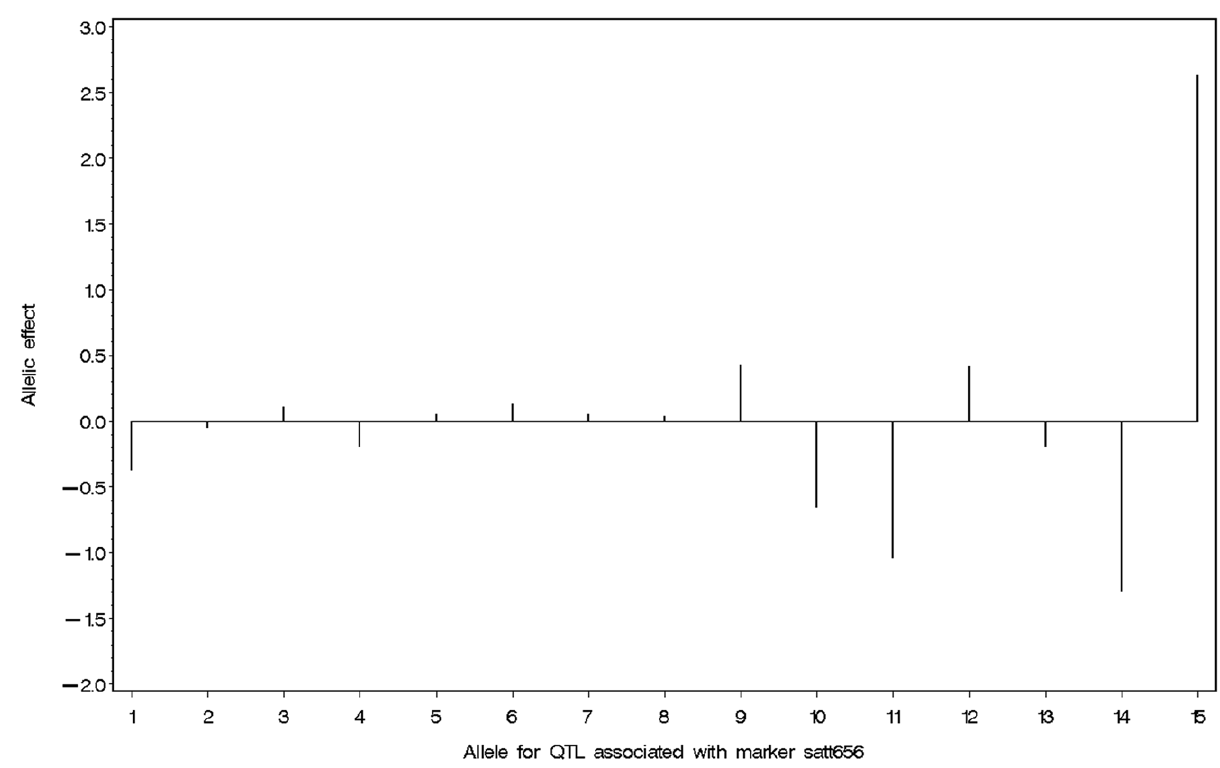
Figure 3. Allelic effects for QTL associated with marker satt656 for soybean seed length (mm).